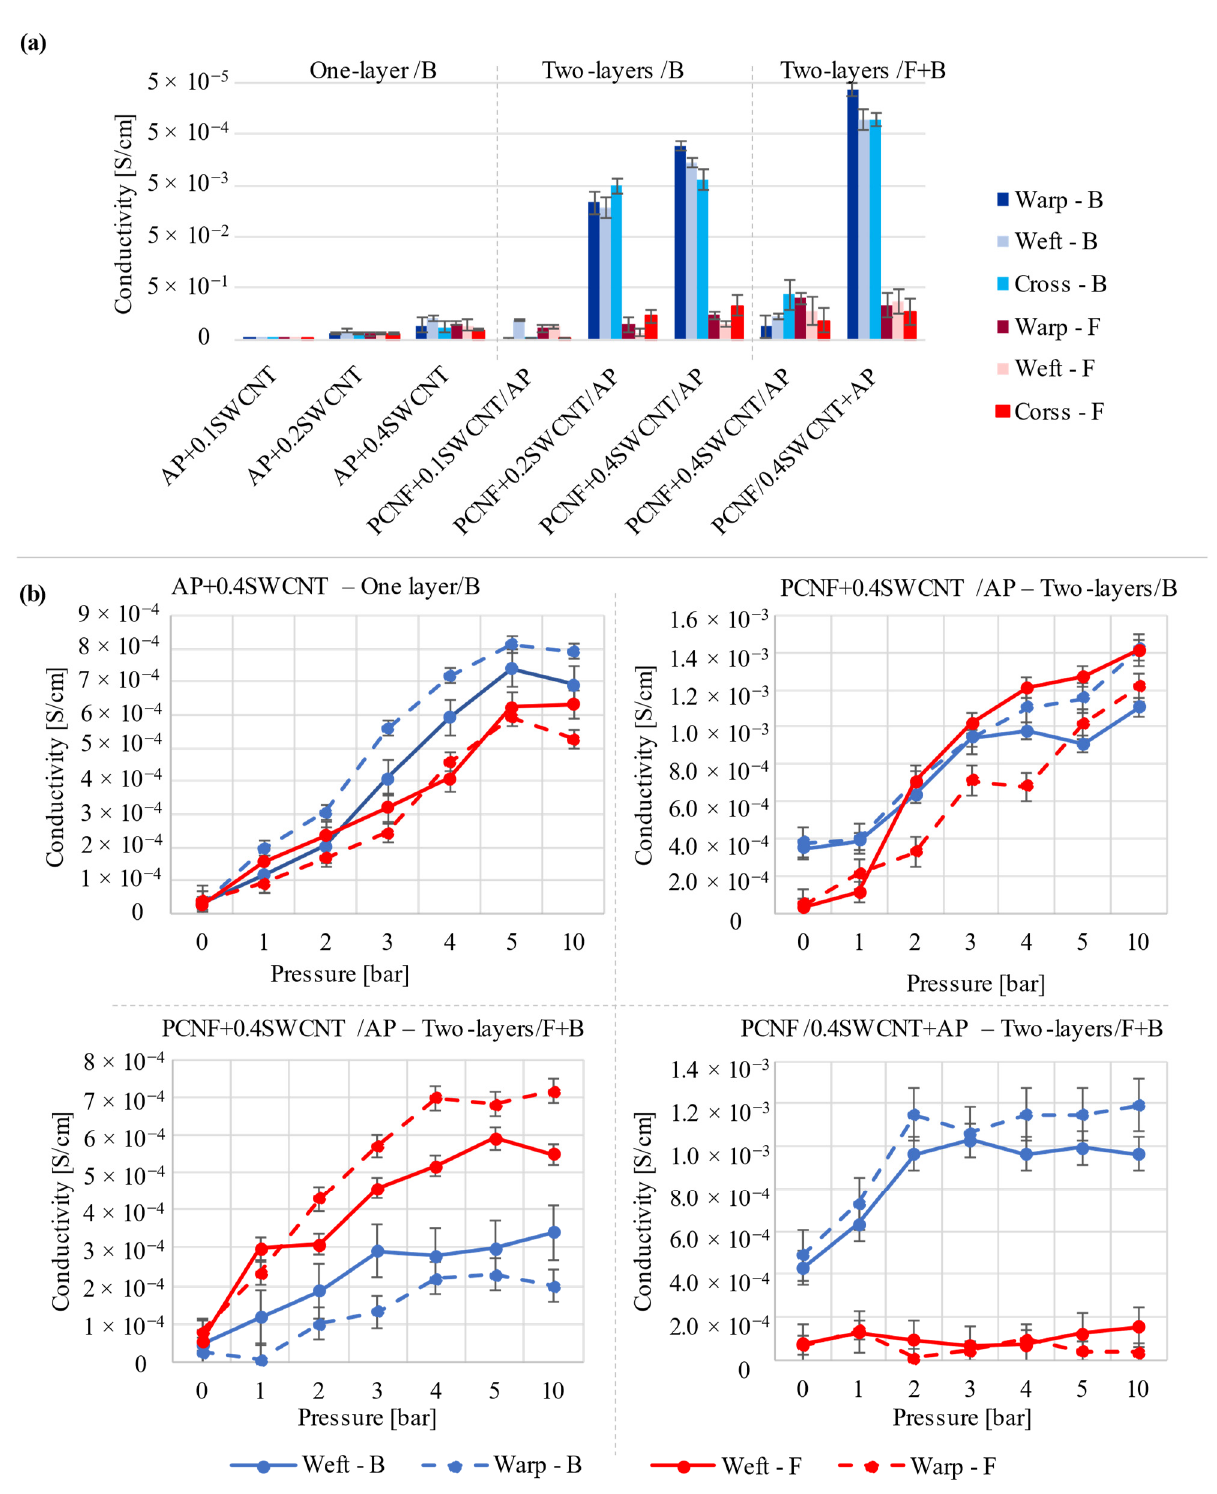
Figure 8. Electrical conductivity of SWCNT treated fabrics, evaluated on both back/B and front/F sides, ( a ) Without and ( b ) With applied different pressures.